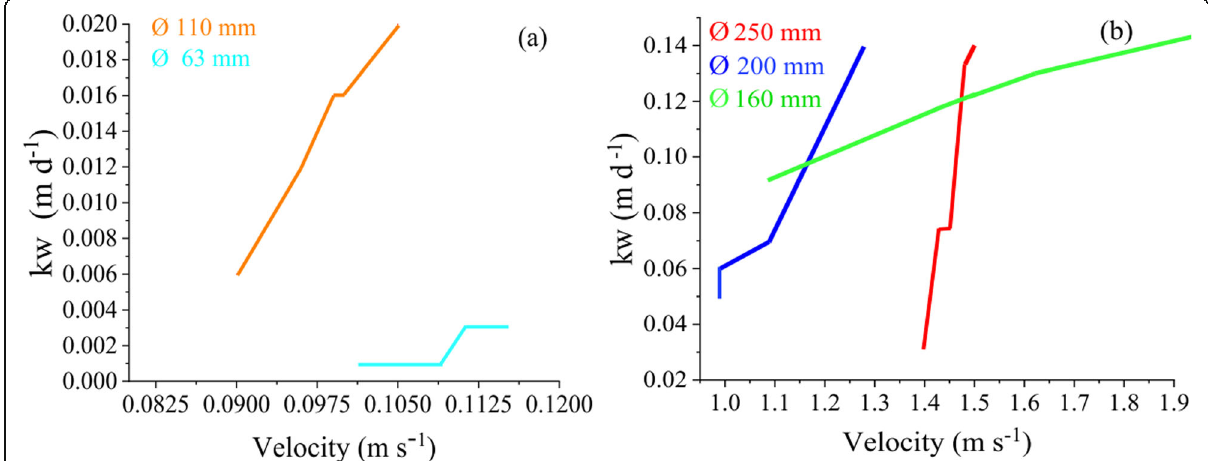
Fig. 3 Variation of kw as a function of the velocity for the different diameters. a For diameter pipelines: 160, 200 and 250 mm b For diameter pipelines: 63 and 110 mm. These figures indicate that the chlorine decay rate with the wall is limited by the water flow velocity in the pipelines